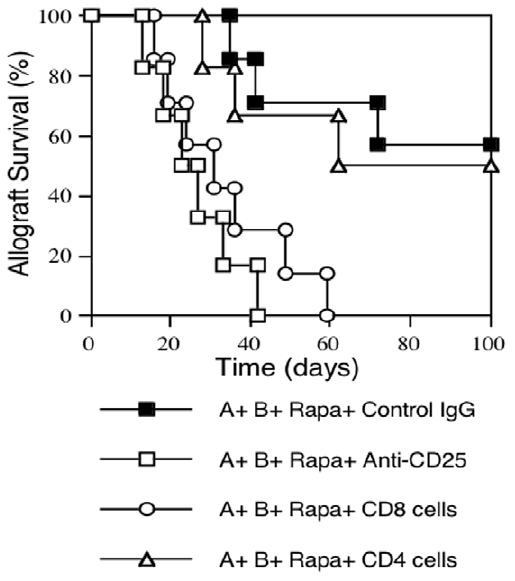
Figure 7. Depleting CD25 + Treg cells or adoptive transfer of pre-sensitized CD8 + T cells abrogates long-term islet allograft survival. B6 mice were treated with MHC I + IL-2/anti-IL-2 and subsequent MHC II + IL-2 prior to transplantation, transplanted with Balb/C islets, and treated with low doses of rapamycin post- transplantation (A + B + Rapa). They were also treated with either depleting anti-CD25 Ab (A + B + Rapa + Anti-CD25) ( % , n=6) or control IgG (A + B + Rapa + Control IgG) ( n , n=7), or received upon trans- plantation syngeneic CD8 + CD25 2 (A + B + Rapa + CD8) ( # , n=7) or CD4 + CD25 2 T cells (A + B + Rapa + CD4) ( , n=6) that were isolated from B6 mice pre-sensitized i.p . with irradiated Balb/C splenocytes two weeks earlier. Depleting CD25 + Treg cells or adoptive transfer of pre- sensitized CD8 + , but not CD4 + , T cells reversed long-term islet allograft survival induced by treatments with donor MHC DNA vaccination and IL-2 regimen prior to transplantation plus rapamycin treatment post- transplantation.